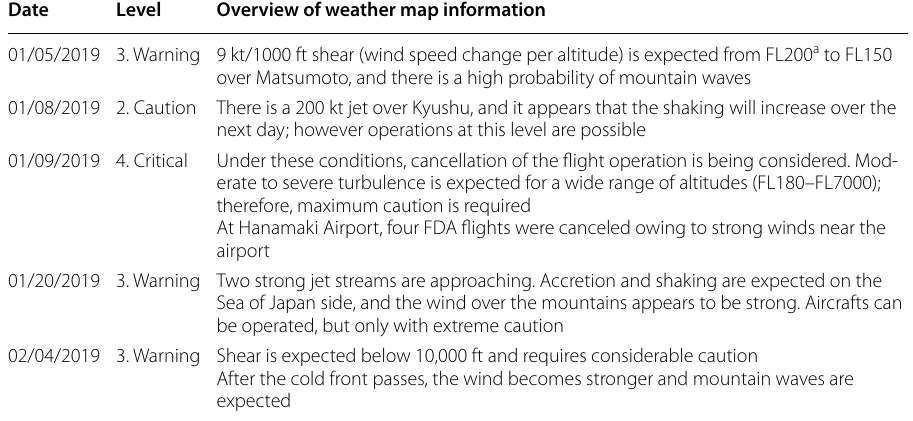
a FL represents the flight level, i.e., aircraft altitude at standard air pressure expressed in 100 s of feet